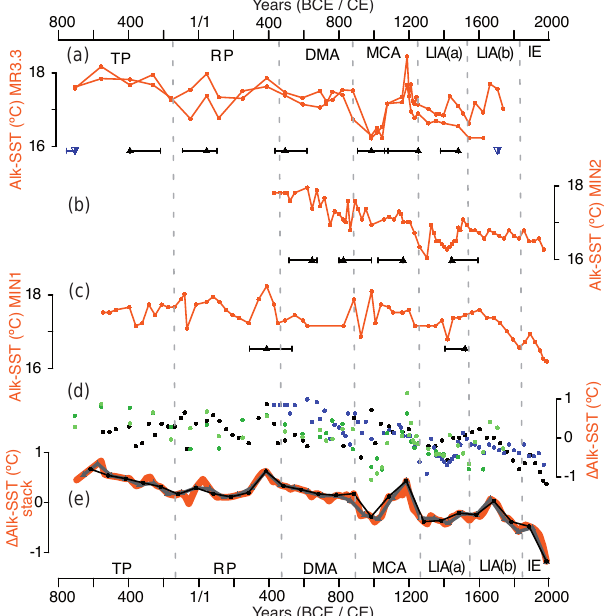
Figure 5. Alkenone temperature records from Minorca (this study) for cores (a) MR3.3, (b) MIN2, and (c) MIN1. Triangles repre- sent 14 C dates (black) and biostratigraphical dates based on plank- tonic foraminifera (blue) and are shown below the correspond- ing core with their associated 2 σ errors. (d) Individual alkenone- derived SST anomalies in their respective time step (MR3.3: green; MIN2: blue; MIN1: black dots). (e) 20yrcm − 1 stacked temper- ature anomaly (orange plot). The 80yrcm − 1 (grey plot) and the 100yrcm − 1 (black plot) stacks are also